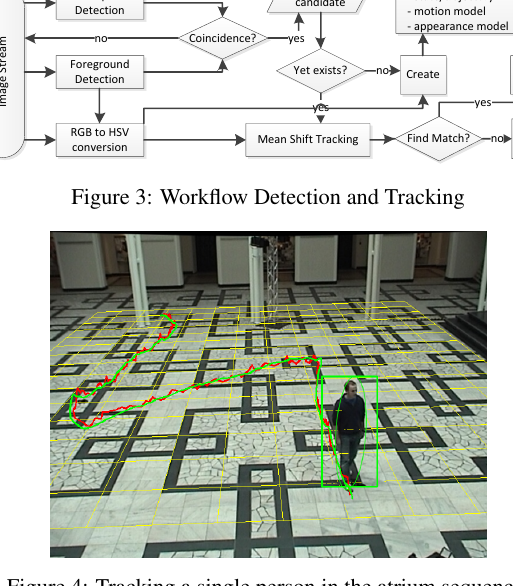
Figure 4: Tracking a single person in the atrium sequence.